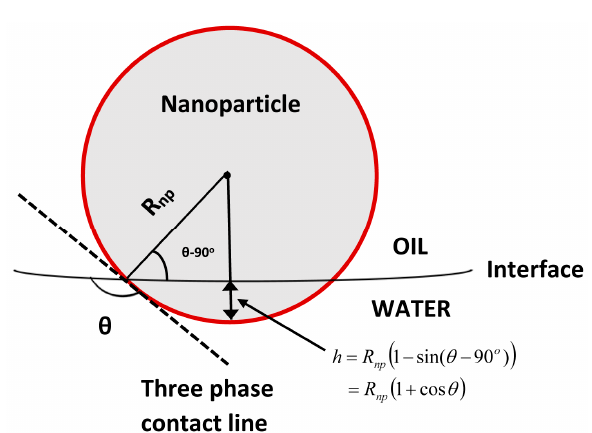
Figure 6. Determination of interfacial thickness of solid nanoparticles protruding into the continuous phase of an emulsion.